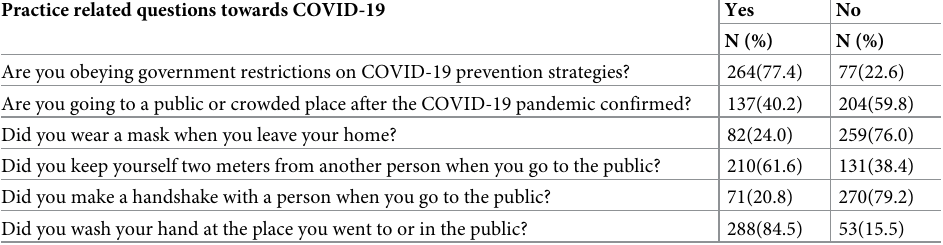
Table 3. Frequency distribution of respondents response on their practice towards Novel Coronavirus (COVID- 19) pandemic in Ethiopia (N = 341). Practice related questions towards